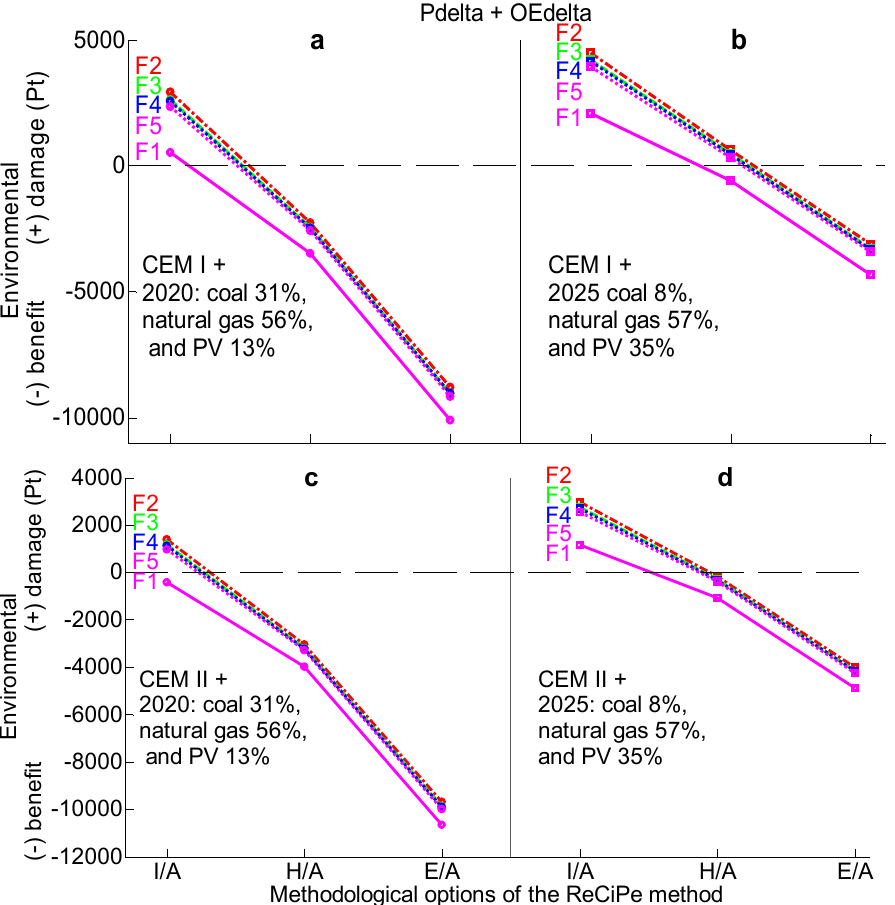
Figure 7. Group F sculptured tiles. Total P + OE stage: environmental damage/benefit of total Pdelta + OEdelta of F1–F5. (a) CEM I + 2020: coal 31%, natural gas 56%, and PV 13%, (b) CEM I + 2025: coal 8%, natural gas 57%, and PV 35%, (c) CEM II + 2020: coal 31%, natural gas 56%, and PV 13%, and (d) CEM II + 2025: coal 8%, natural gas 57%, and PV 35%. Evaluation was performed with ReCiPe2016 endpoint single-score method using individualist/average (I/A), hierarchist/average (H/A), and egalitarian/average (E/A) options.